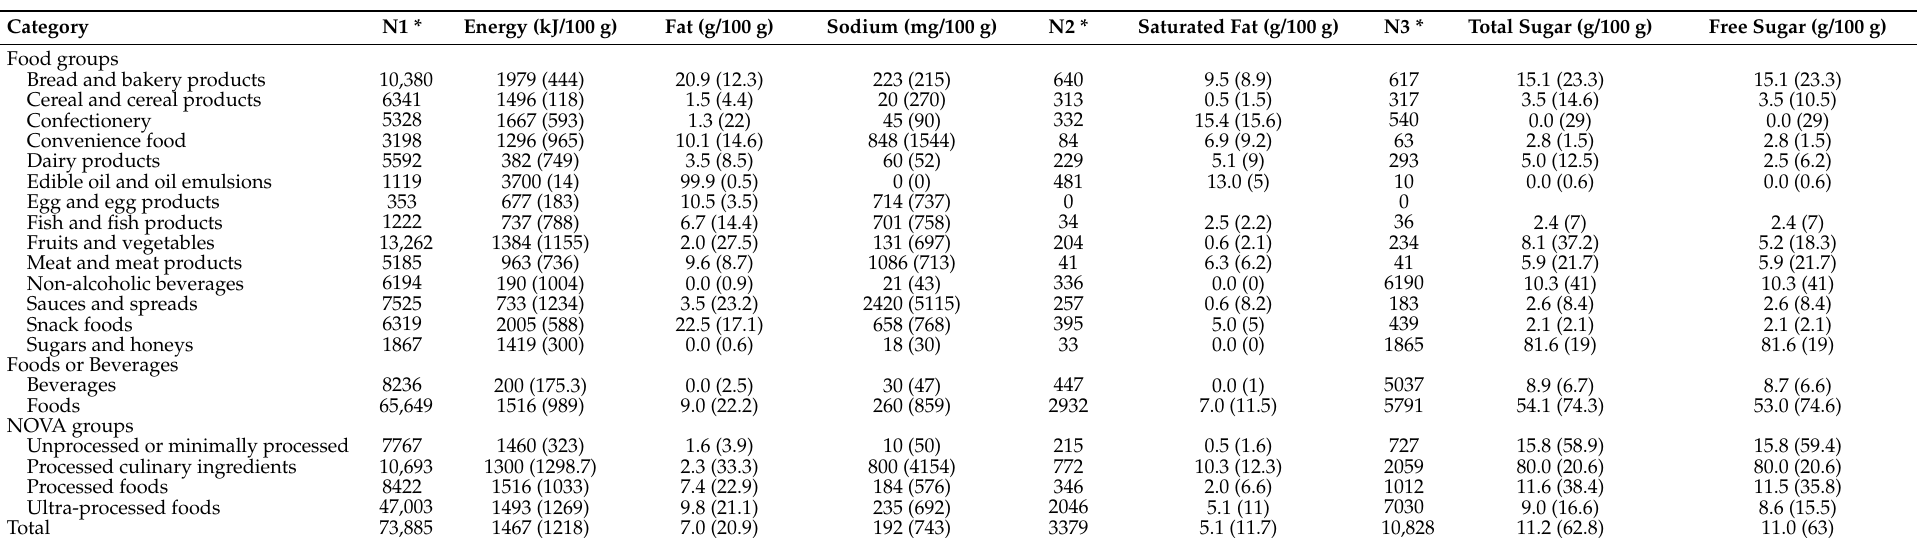
Table 2. Nutrient content of food products by food categories, median